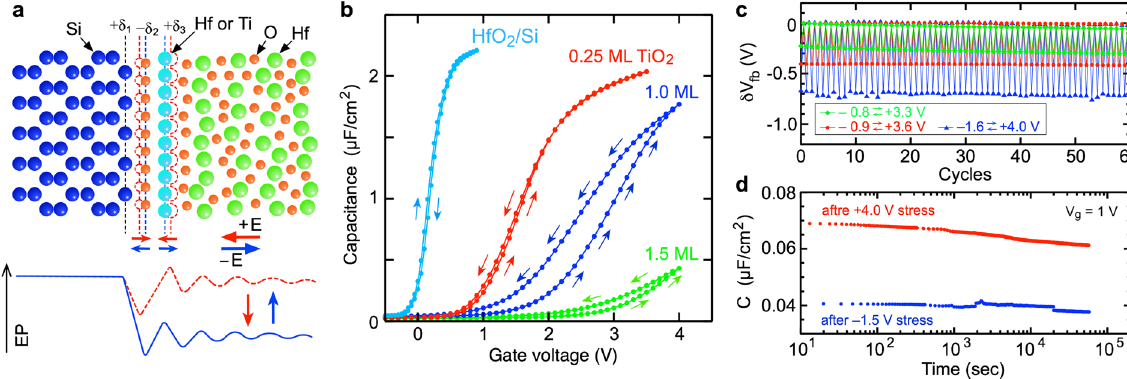
Figure 1. Interface dipole modulation (IDM) concept and experimental demonstration at the HfO 2 /Si interface. (a ) Schematic illustration of dipole formation and IDM operation at the HfO 2 /Si interface. Large interface dipoles are observed from the HfO 2 /Si structures, which are reasonably explained by the bond polarity mechanism, from ref. 29 . The IDM operation utilizes this mechanism. Dipole strength changes due to the atomic displacement induced by the electric field. ( b ) Effect of the interface TiO 2 layer on the high-frequency capacitance-voltage ( C-V ) curves of the 5.5-nm-thick HfO 2 /Si MOS capacitors fabricated on n-type Si substrates. Double sweep measurements were performed in the voltage ranges between − 1.0 V and the positive voltages shown in this figure. Counterclockwise hysteresis suggests that the IDM behavior appears for the HfO 2 /1-monolayer (ML) TiO 2 /Si structure. ( c) Cyclic operation of the HfO 2 /1-ML TiO 2 /Si IDM device under various voltage sweep conditions. ( d ) Retention characteristics of the HfO 2 /1-ML TiO 2 /Si IDM device.